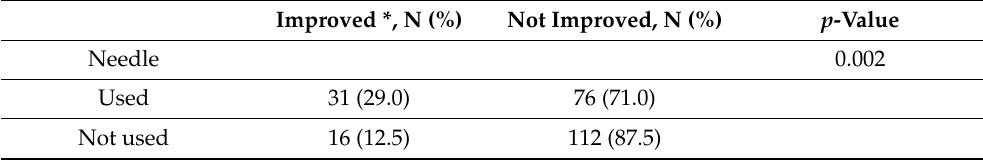
Table 6. Additional univariable analysis of changes in R-EBUS findings using TBNA.